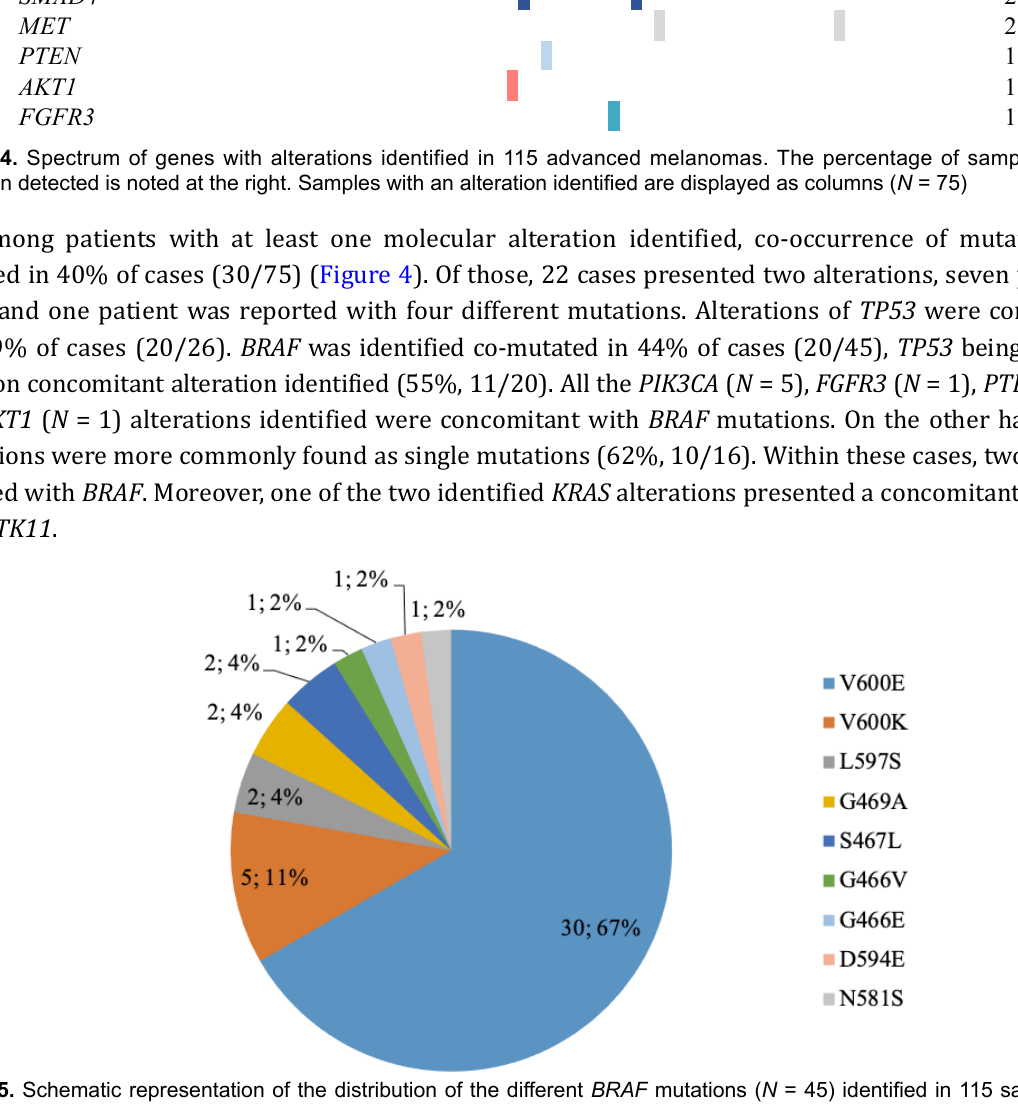
Explor Target Antitumor Ther. 2020;1:101-108 | https://doi.org/10.37349/etat.2020.00006